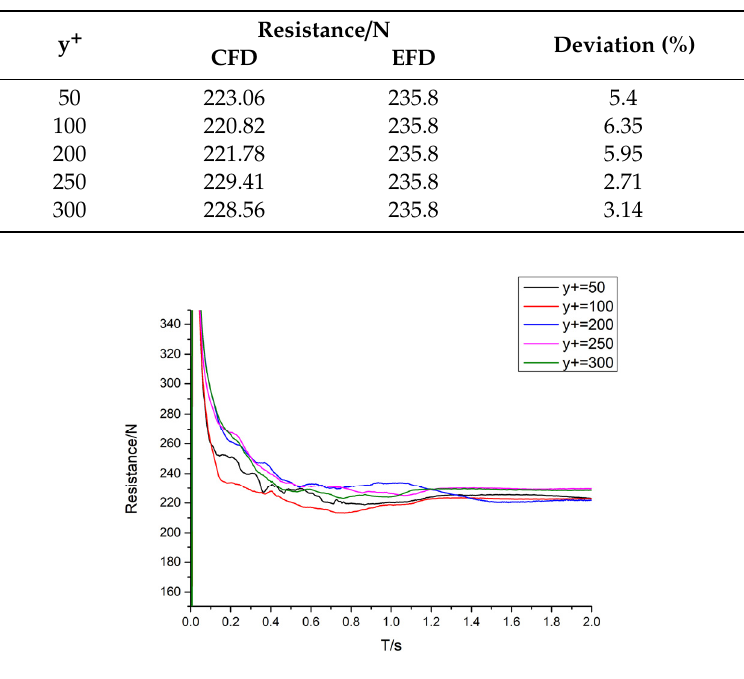
Figure 11. The resistance curve of different y+ s.